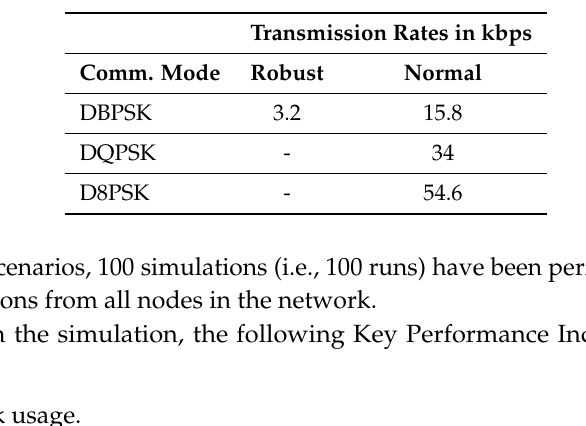
Table 9. Transmission speeds for the different communication modes available in